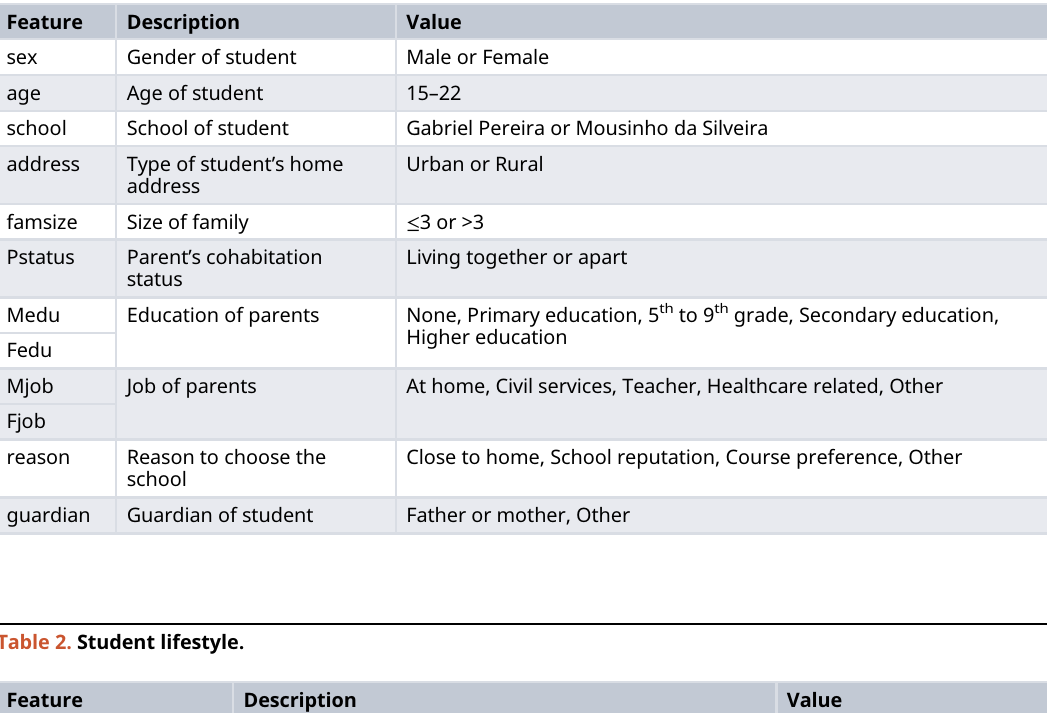
Table 2. Student lifestyle. Feature